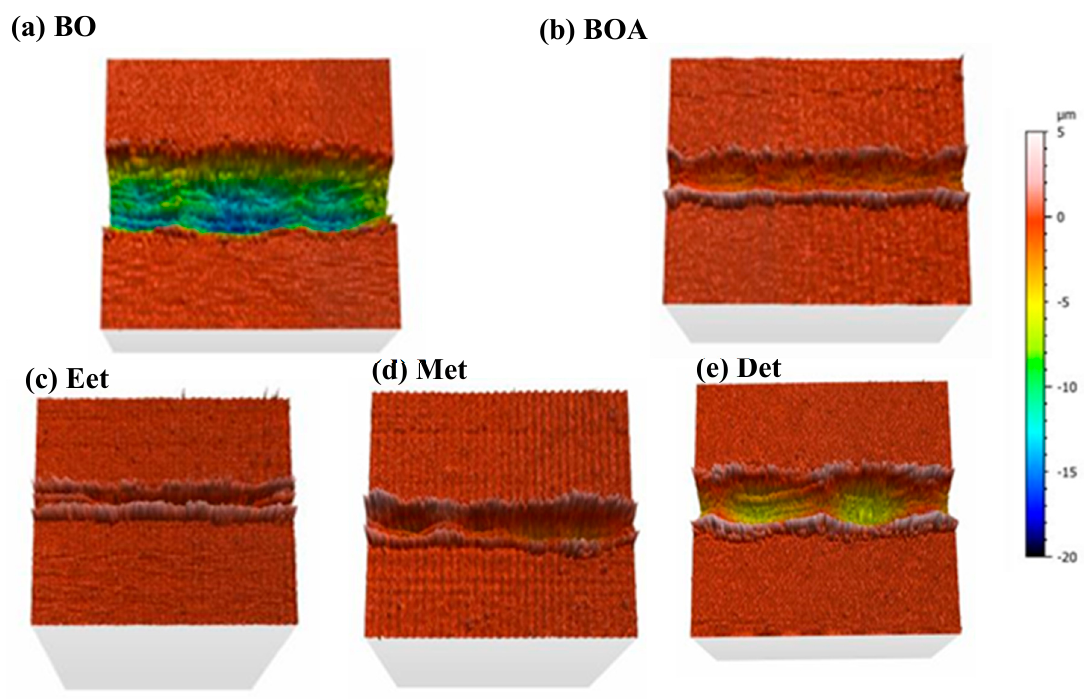
Figure 8. Three-dimensional (3D) surface profiles on steel surfaces after tests lubricated with ( a ) BO, ( b ) BOA, ( c ) Eet, ( d ) Met, and ( e ) Det.